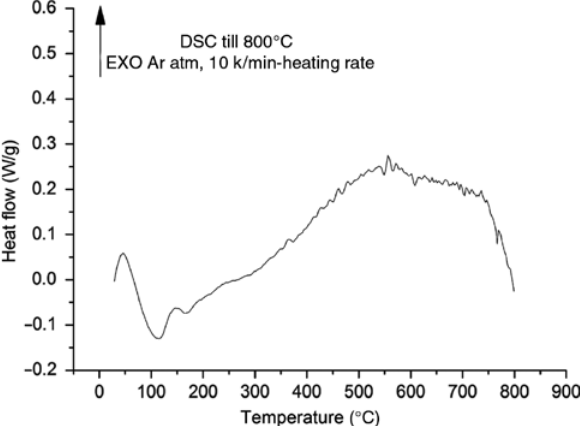
Figure 2: DSC curve of 15 h milled AlMgNiCrTi HEA powders.